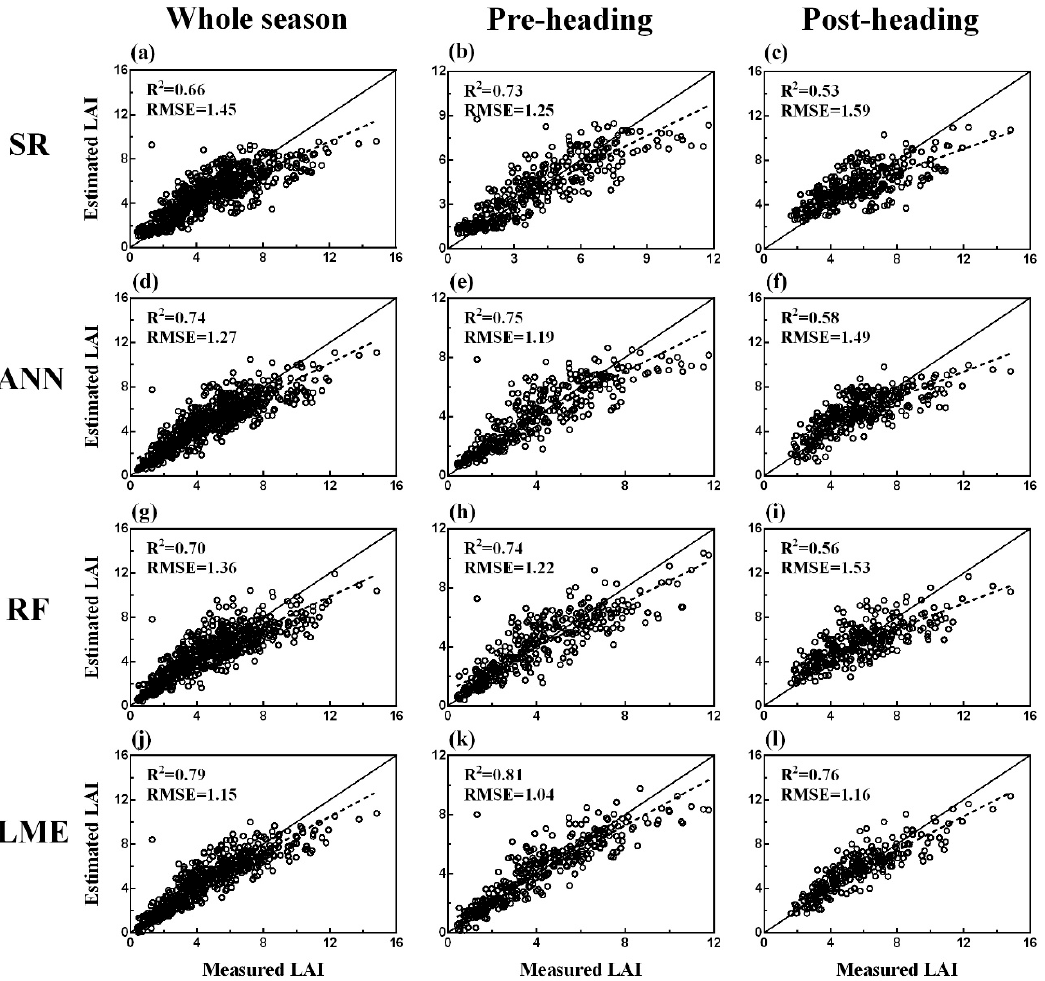
Figure 8. Validation of LAI estimation models for the whole season and di ff erent stage groups: ( a ) SR for the whole season, ( b ) pre-heading stages and ( c ) post-heading stages; ( d ) ANN for the whole season, ( e ) pre-heading stages and ( f ) post-heading stages; ( g ) RF for the whole season, ( h ) pre-heading stages and ( i ) post-heading stages; ( j ) LME model for the whole season, ( k ) pre-heading stages and ( l ) post-heading stages.